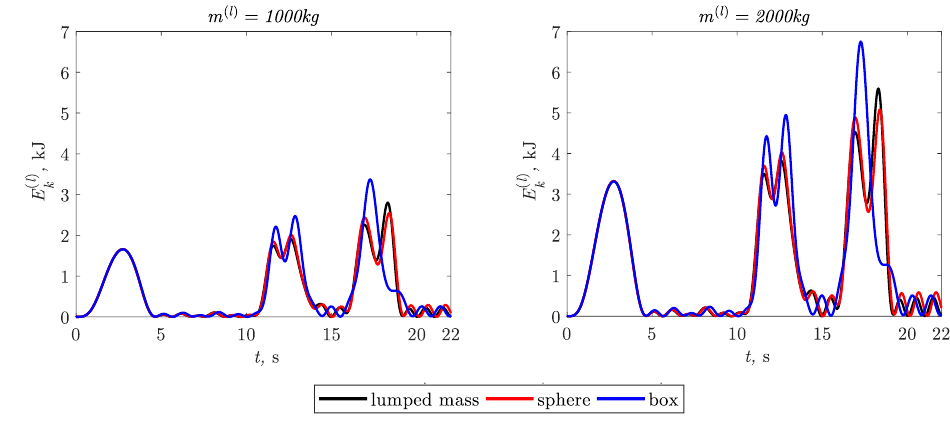
Figure 4. Time courses of the kinetic energy of the loads. The influence of load modeling methods on the kinetic energy of the load was esti‑ mated using following energy indicators: − kinetic energy integral mean value (Figure 5)